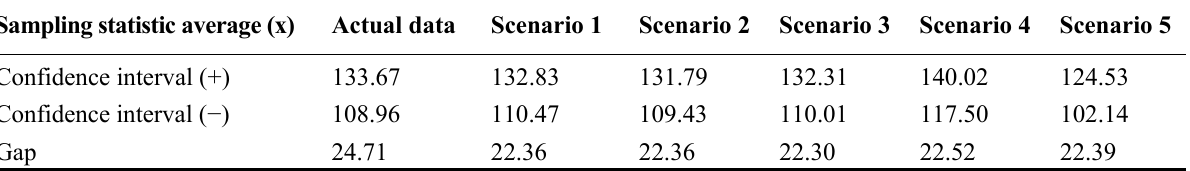
Table 12. Scenarios confidence interval of statistical